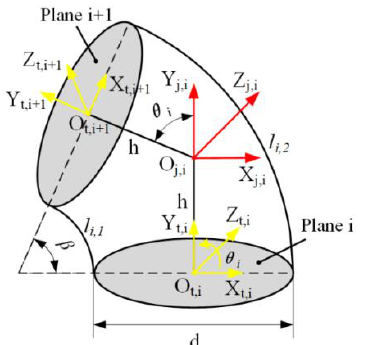
Figure 6. The kinematic model of a single joint.